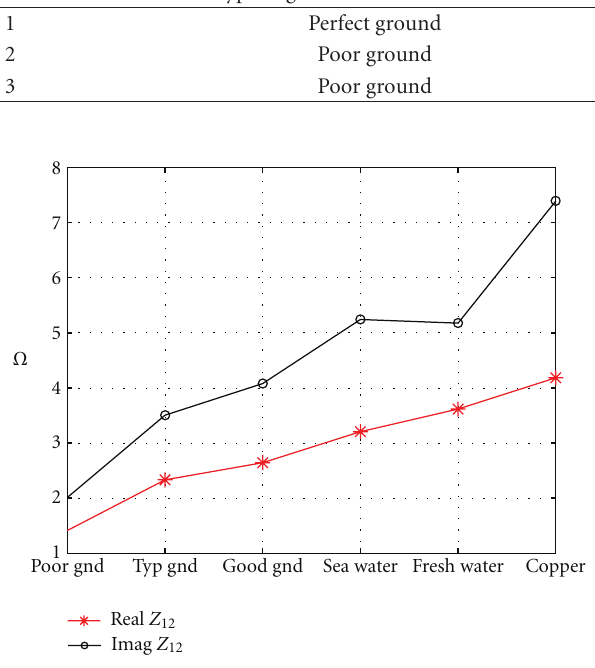
Figure 3: Mutual coupling between two λ/ 4 monopoles for various ground types at 2.4 GHz. Figure 4: Mutual coupling between two λ/ 4 monopoles at 2.4 GHz for σ = 10 − 3 to 10 7 S/m, (cid:2) r =